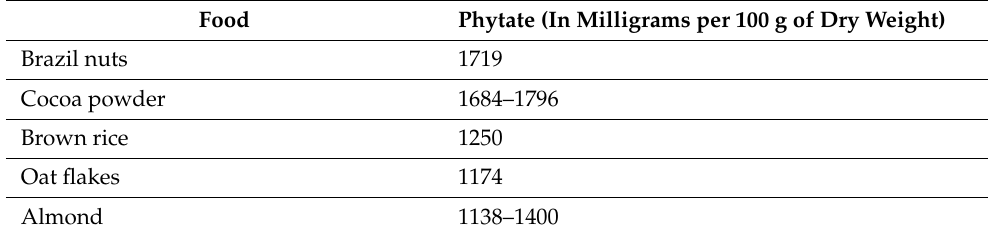
Table 2. Phytate content of different plant foods (derived from